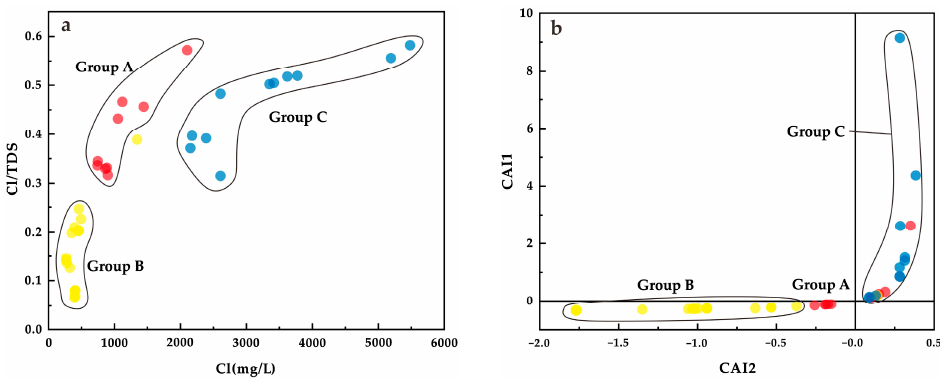
Figure 6. ( a ) Relationships between the Cl/TDS ratio; ( b ) relationships between CAI1 and